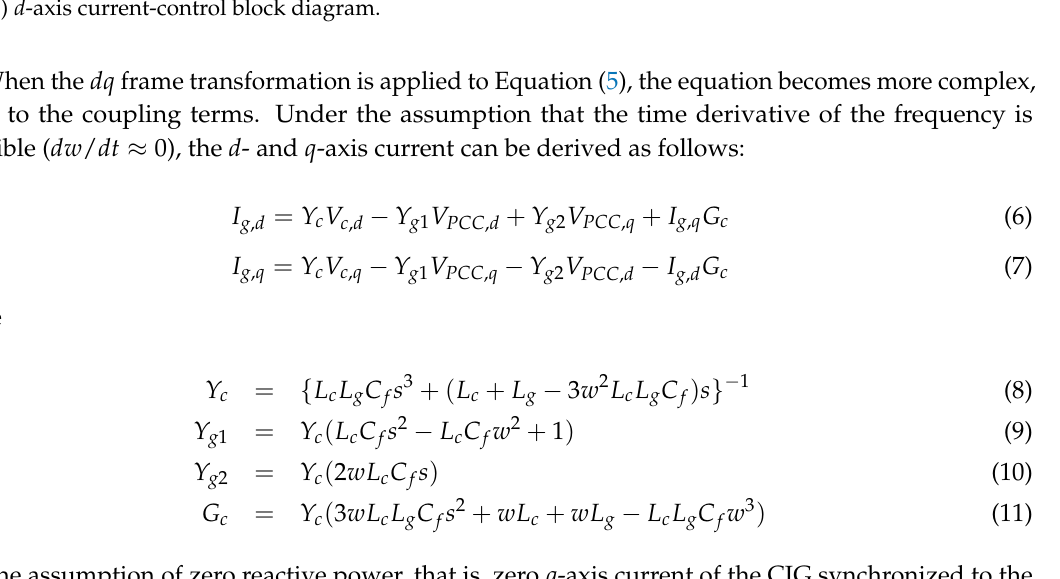
Figure 4. Circuit diagram and control system of the power converter: ( a ) overall control system and ( b ) d -axis current-control block